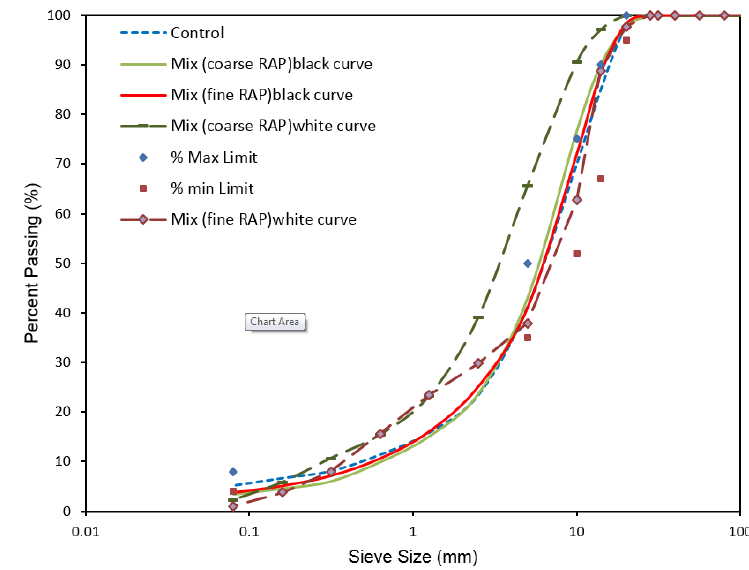
Figure 4. Mixes gradation.